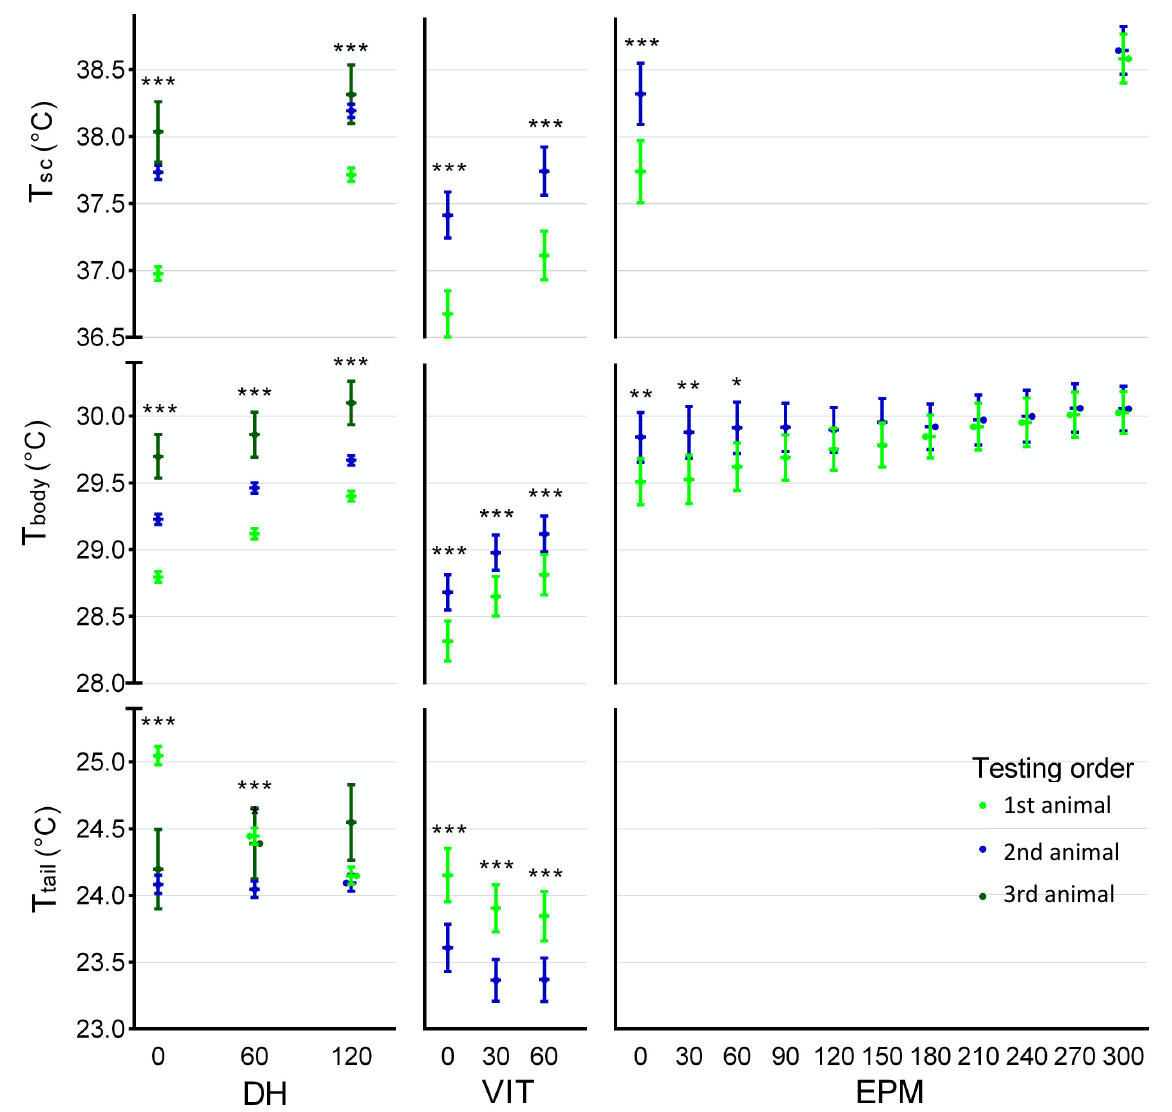
Figure 7. T sc , T body and T tail during Daily Handling (DH), Voluntary Interaction Test (VIT) and Elevated Plus Maze (EPM), at predefined time points, presented for effect of testing order (1st animal from cage tested—light green, 2nd animal from cage tested—blue, 3rd animal from cage tested—dark green). Error bars represent 95% CI, * p < 0.05, ** p < 0.01, *** p < 0.001.